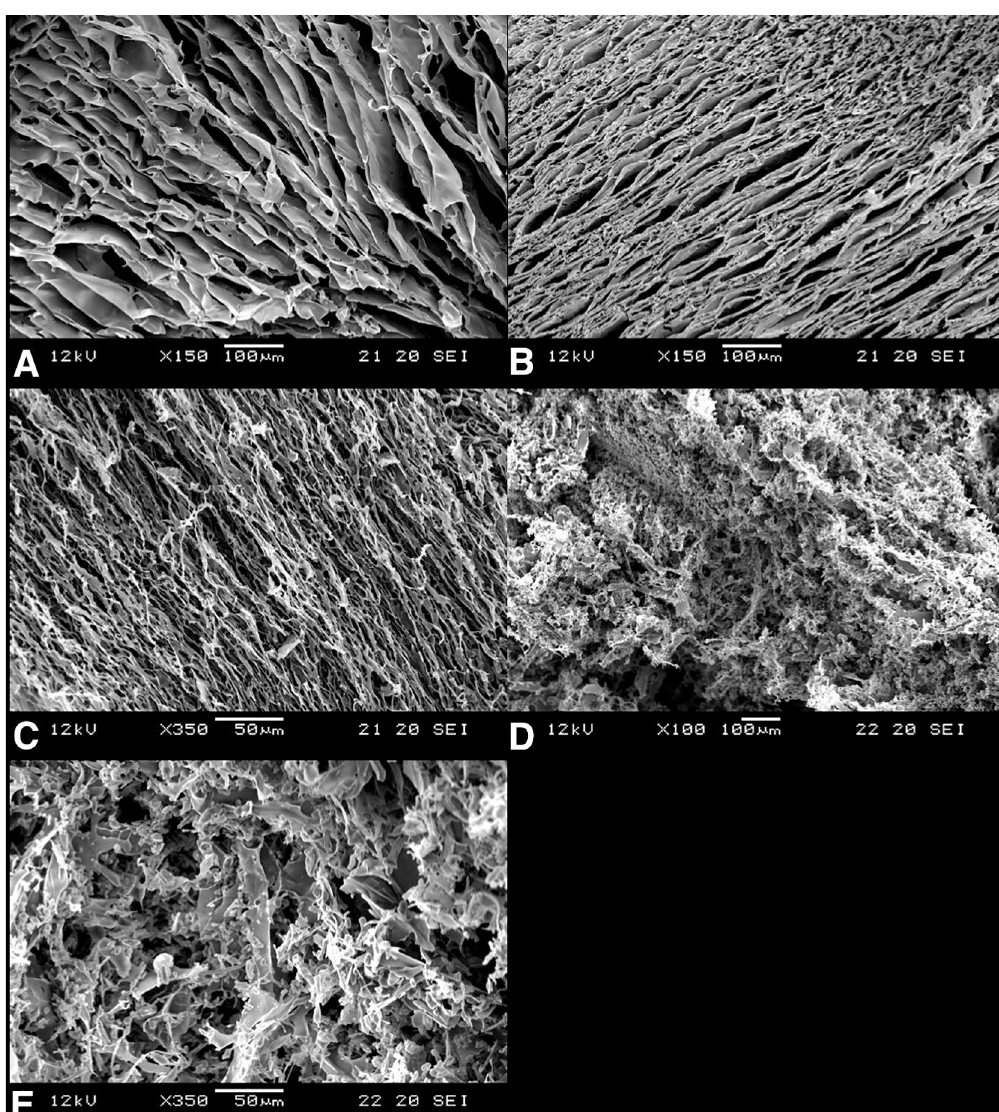
Fig 5. The SEM images of (A) mPA (blank), (B) M10/mPA (mPA+ 1000 μ g/mL MNP), (C) H1/mPA (mPA+ 100 μ g/mL HAP), (D) H5/mPA (mPA + 500 μ g/mL HAP) hydrogels, and (E) the magnification of H5/mPA.